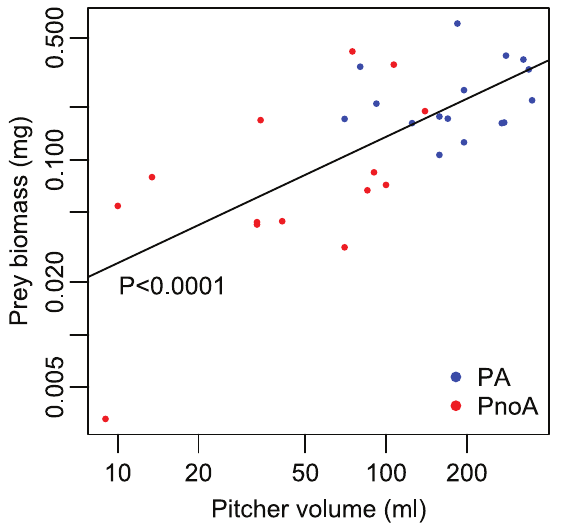
Figure 4. Positive effect of Camponotus schmitzi on pitcher volume and prey biomass. Prey biomass accumulated during the entire life of a lower pitcher as a function of pitcher volume (logarithmic scales). Blue and red points refer to PA and PnoA plants, respectively. A common regression line was estimated for these two categories, the means of which were significantly different.